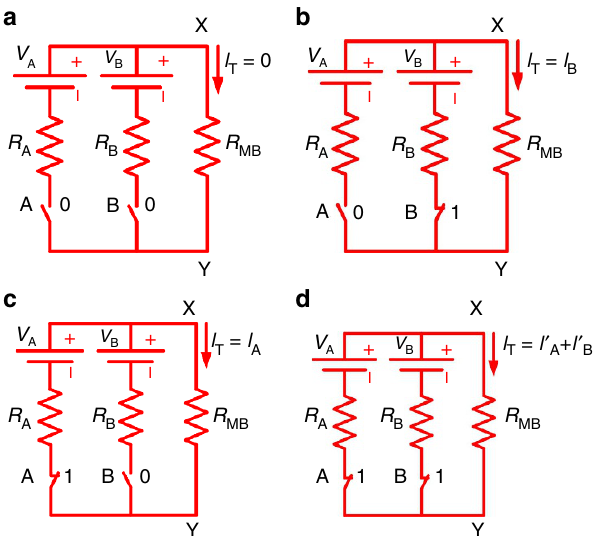
Figure 2 | Electrical circuit configuration of the logic input conditions.